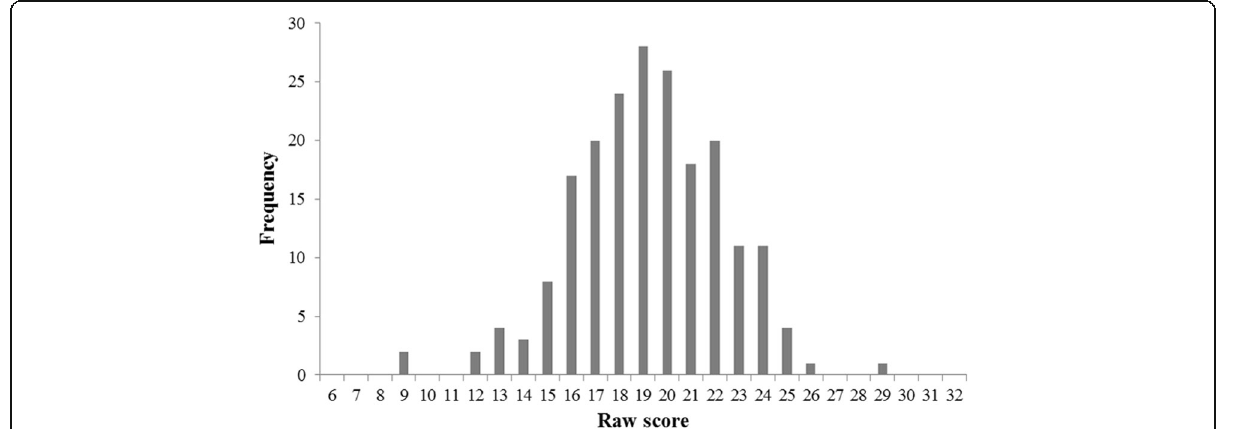
Fig. 6 Distribution of experimental group ’ s performance on the Crowds test